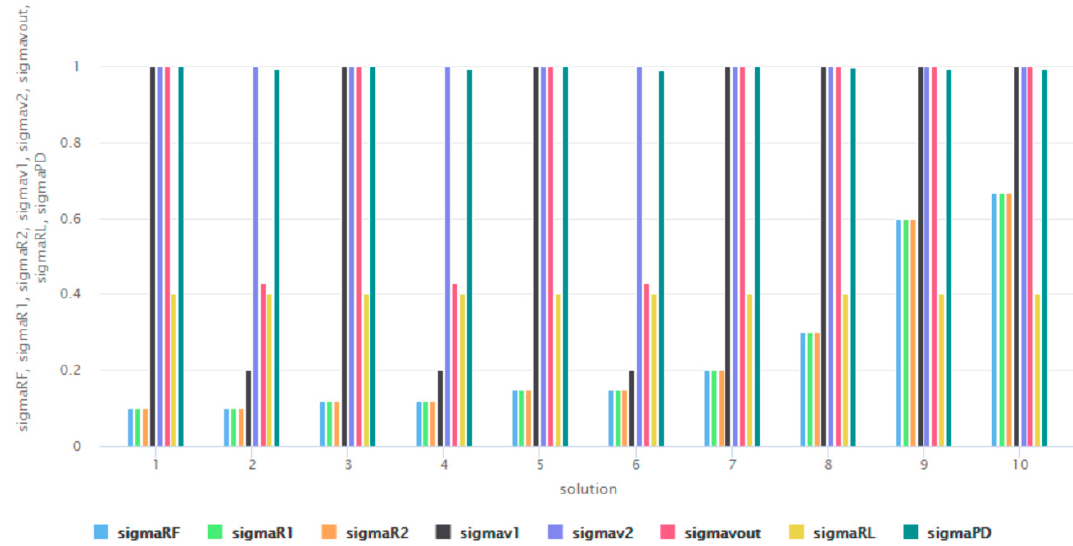
Figure 4. Membership values of ten random solutions at design of inverting summing amplifier.